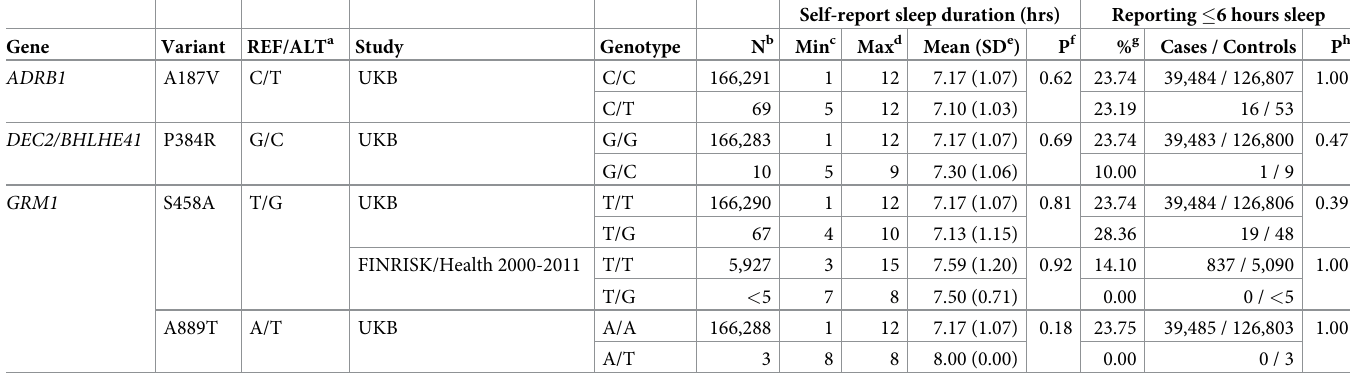
Table 2. Summary of self-reported sleep duration in UK Biobank (data field 1160) between carriers of variants previously reported to be causal for familial natural short sleep and non-carriers (homozygous reference called by UK Biobank exome-sequencing) who are also non-carriers for any of the other 12 variants described in this